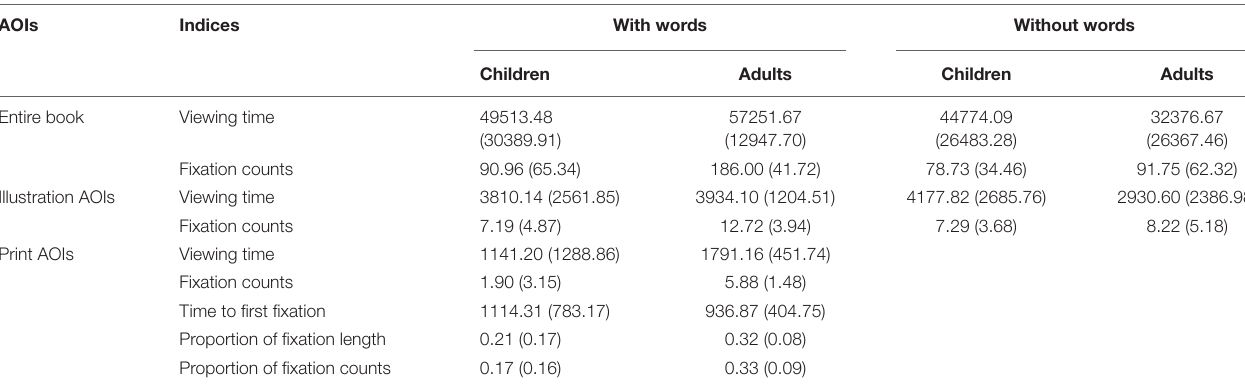
TABLE 3 | Mean scores (and standard deviations) of indices of each areas of interest (AOI) in picture books with and without words for each group.